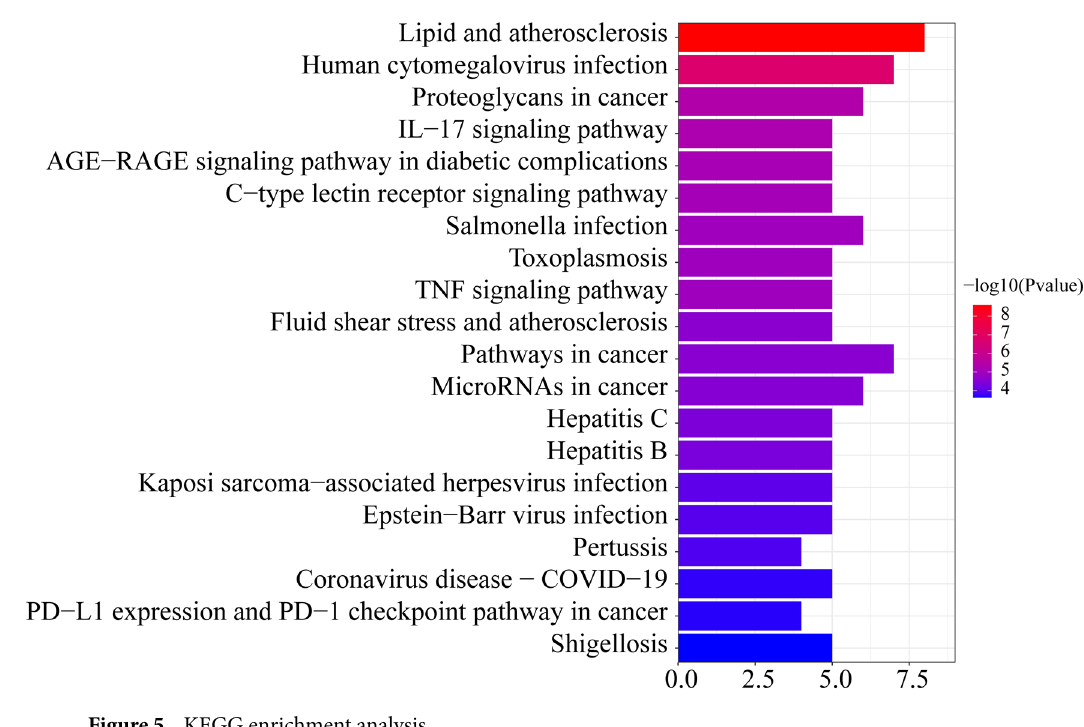
Figure 5. KEGG enrichment